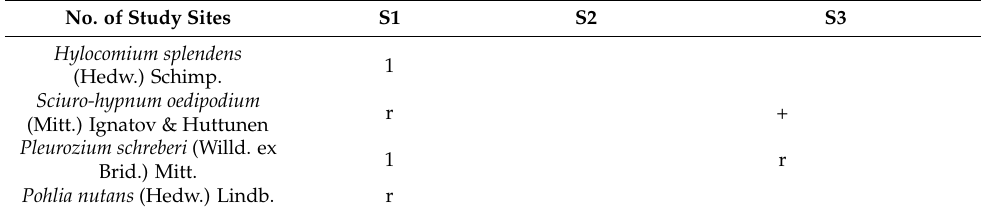
Table 2. Cont. No. of Study Sites S1 S2 S3 Hylocomium splendens (Hedw.) Schimp.